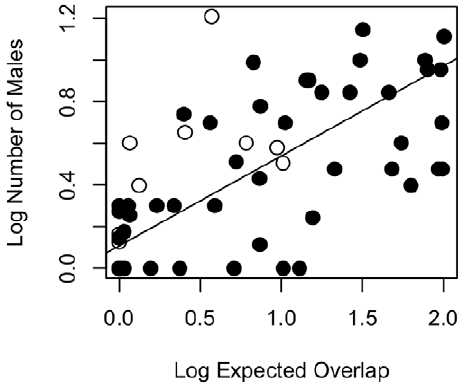
Figure 4. Association between number of males and expected estrous overlap. Data are log 10 transformed. The regression slope of 0.432 was obtained as the mean of the posterior probability distribution from regressing the number of males on estrous overlap and controlling for phylogeny (R 2 =0.47, lambda=0.29). All 10,000 sampled regression coefficients were positive. The intercept of 0.108 was also obtained from the phylogenetic analysis. Haplorhines are represented with black circles and strepsirrhines with open circles.